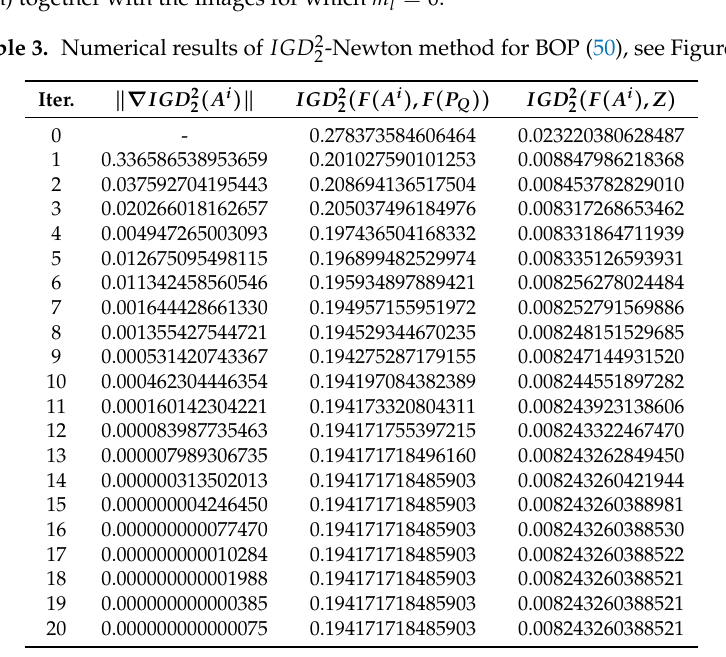
Table 4. Numerical results of IGD 2